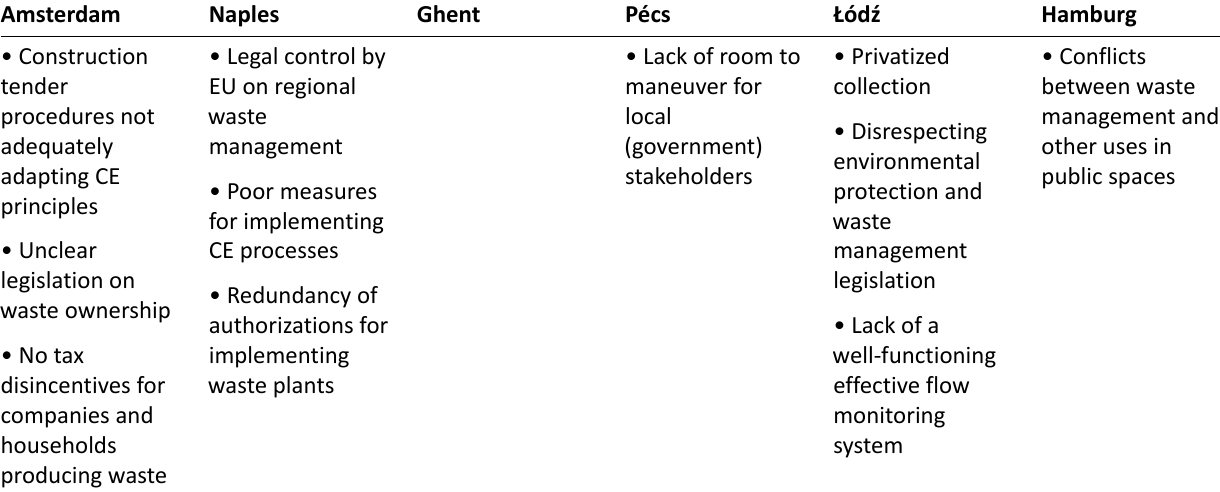
Table 7. Governance challenges: Legal.